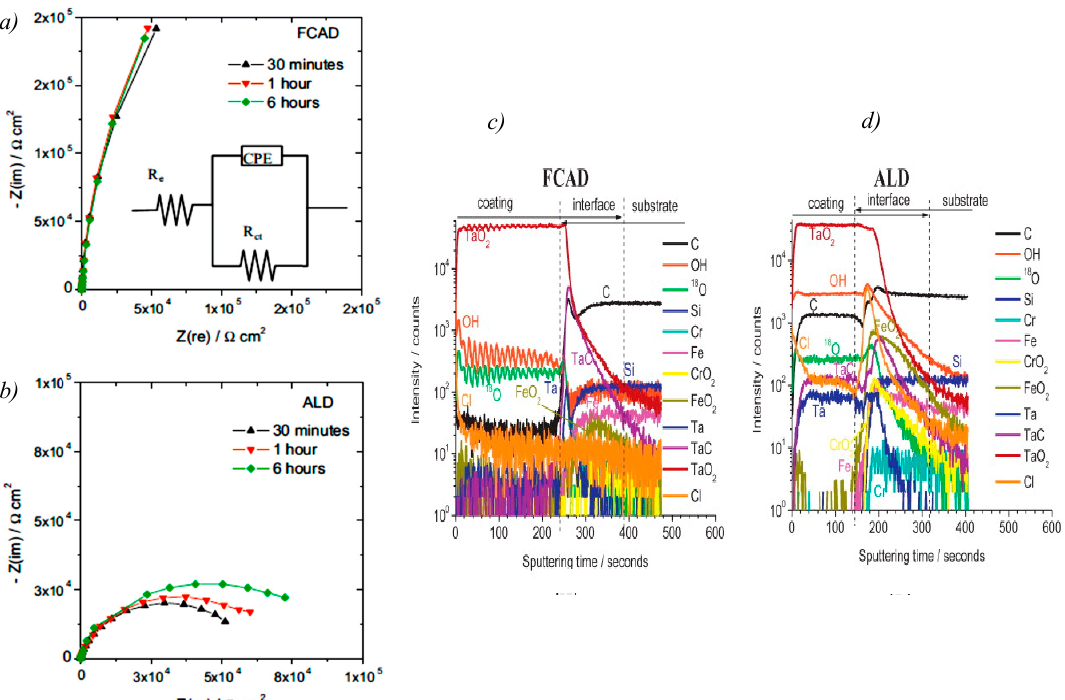
Figure 15. Nyquist plots for the filtered cathodic arc deposition (FCAD) ( a ) and ALD ( b ) coated 100Cr6 substrate during immersion in neutral 0.2 ‐ M NaCl solution. Time ‐ of ‐ flight secondary ions mass spectrometry (ToF ‐ SIMS) negative ions depth profiles for the 50 ‐ nm tantalum oxide layer prepared by FCAD ( c ) and ALD ( d ) on the 100Cr6 substrate [95].